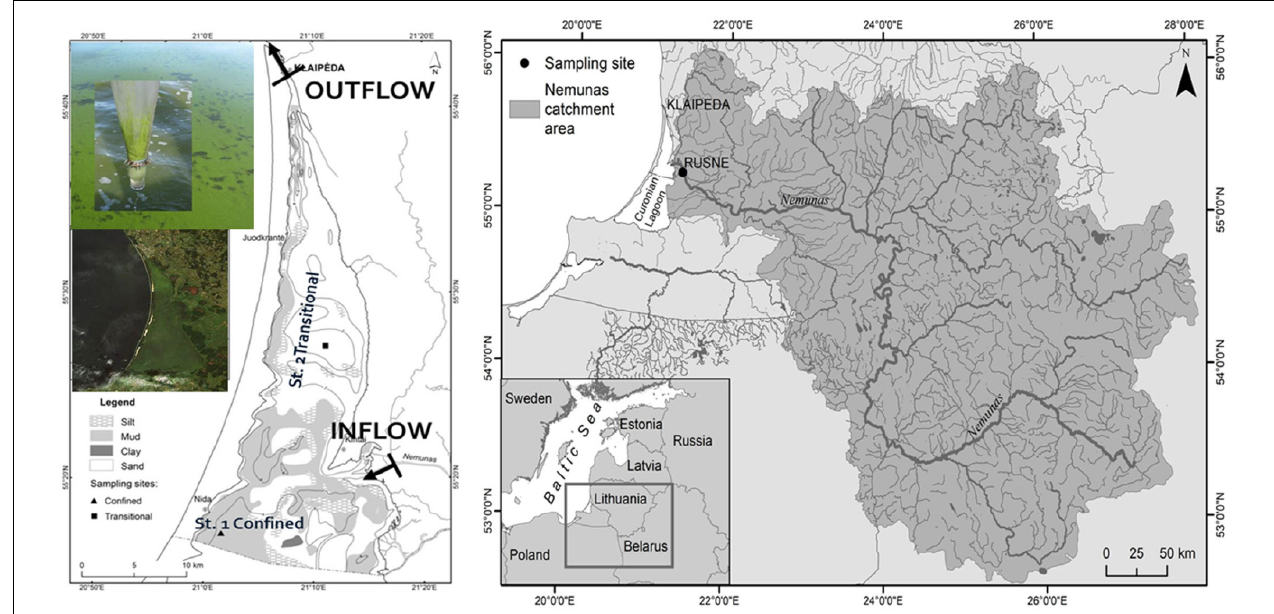
FIGURE 1 | Maps of the Nemunas River watershed (right) and the Lithuanian part of the Curonian Lagoon (left). The lagoon map includes water sampling stations at the lagoon inlet and outlet, and the main sediment sampling sites located at the confined muddy and transitional sandy areas. Color photos show the Curonian Lagoon during a summer cyanobacteria